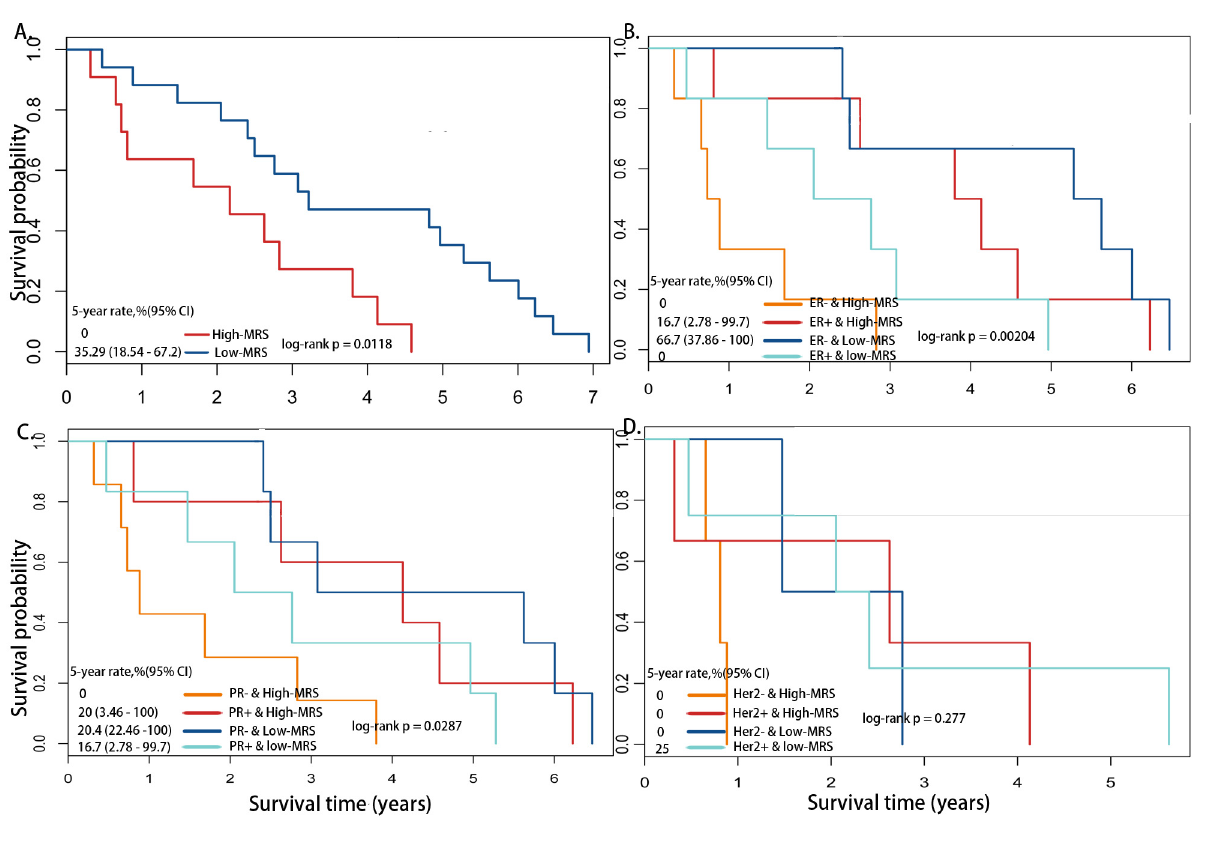
Fig 3. Kaplan-Meier survival analysis of overall survival on 28 patients with death outcome. (A) Survival comparison between High-MRS and Low- MRS groups. (B) Survival comparison among ER+/- patients. (C) Survival comparison among PR+/- patients. (D) Survival comparison among Her2+/-